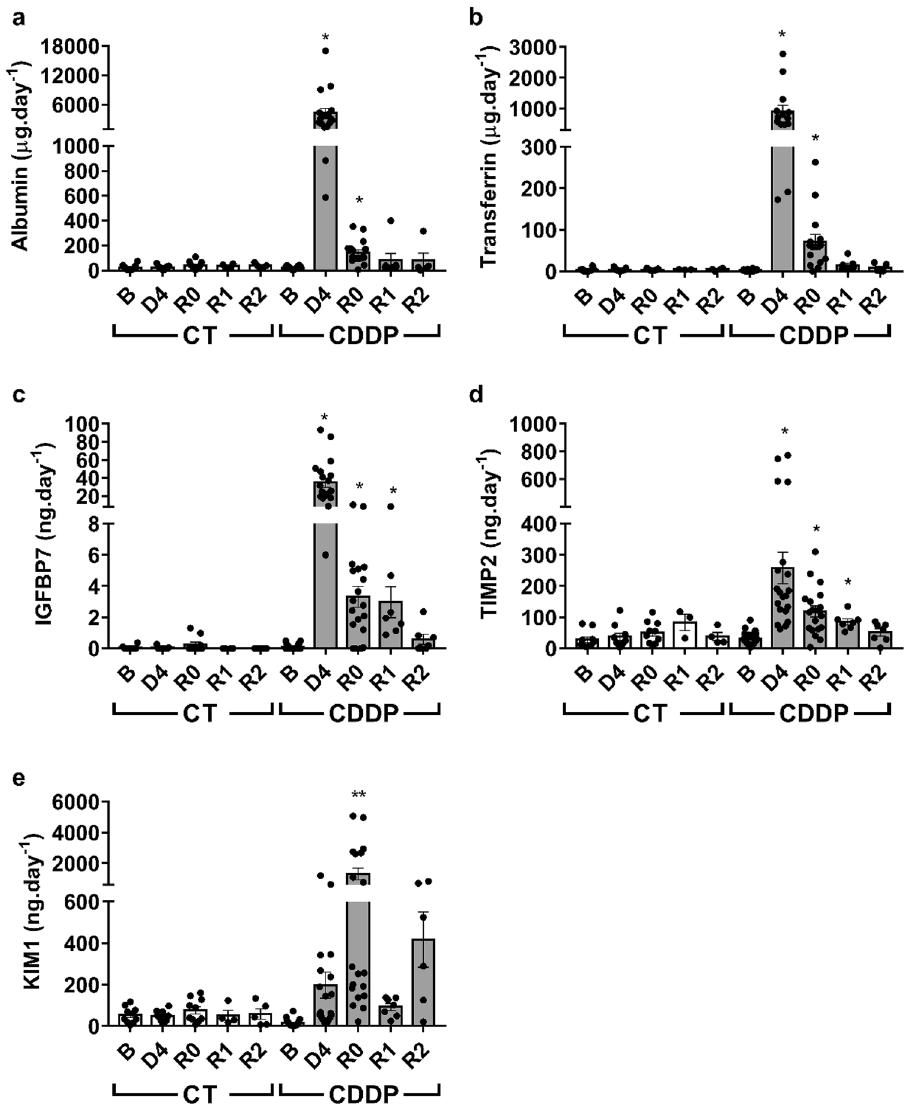
Figure 6. Urinary excretion of biomarkers. Albumin ( a ), transferrin ( b ), IGFBP7 ( c ), TIMP-2 ( d ) and KIM-1 ( e ) urinary excretion. B basal, CDDP cisplatin treatment (5 mg kg −1 body weight) group, CT control group, D4 day of maximum kidney damage after cisplatin treatment, R0 day of recovery, R1 1 week after recovery, R2 2 weeks after recovery. P < 0.05: * versus B; P < 0.01: ** versus